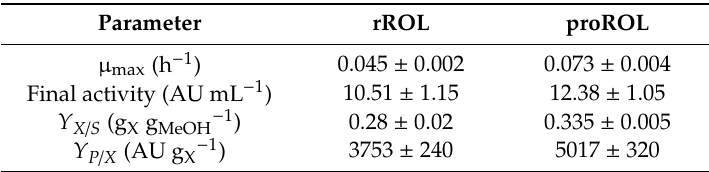
Table 1. Results of the batch with 10 g methanol L − 1 .